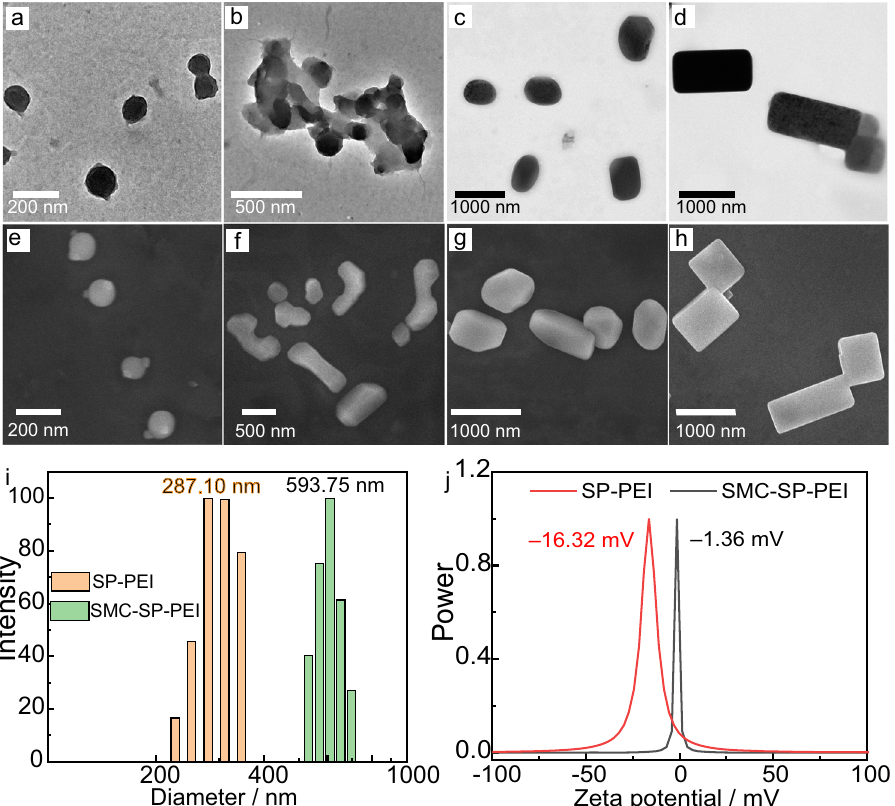
Fig. 3 Characterization of the supramolecular DSAs. a – d TEM images of SP-PEI nanoparticles and their gradual change to SMC-SP-PEI nanoparticles. e – h SEM images of SP-PEI nanoparticles and their gradual change to SMC-SP-PEI nanoparticles. i DLS of SMC-SP-PEI and SP-PEI. j Zeta potential of SMC- SP-PEI and SP-PEI. ([SMC] initial = 0.225 mM, [PEI] = 5 μ g mL − 1